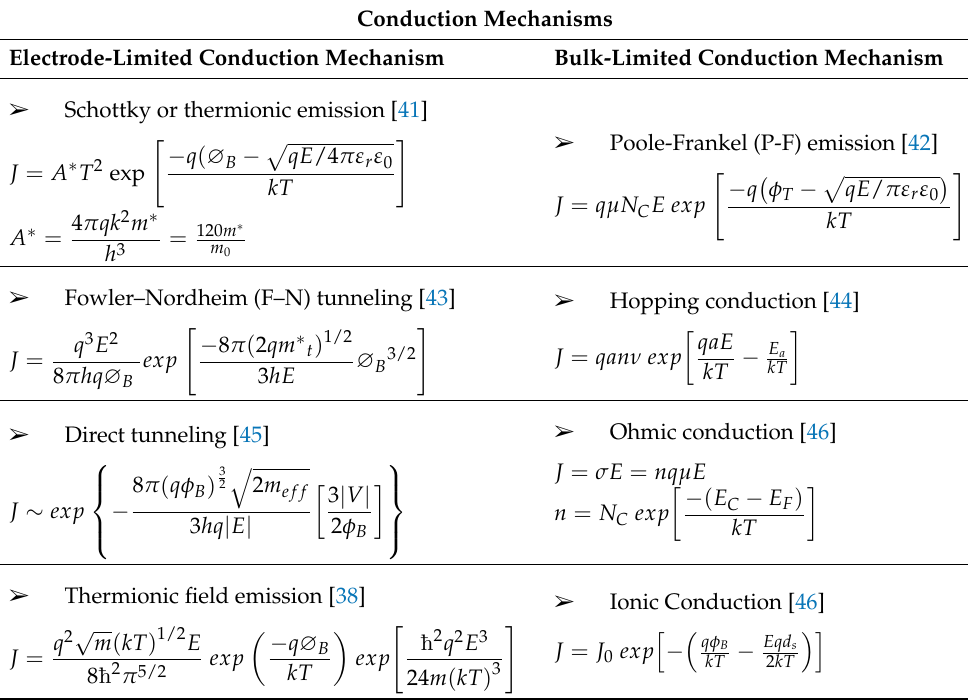
Table 1. Classification of the conduction mechanisms and their equations.